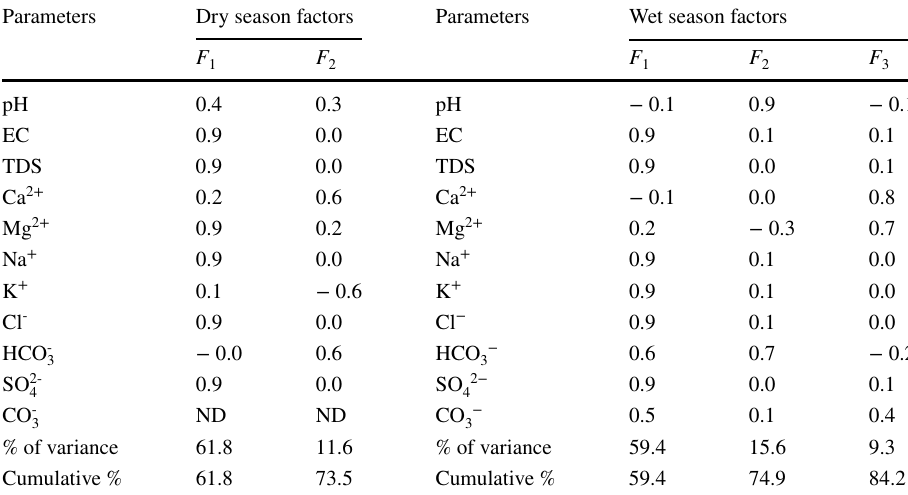
Table 5 Factor analysis matrix in the dry and wet